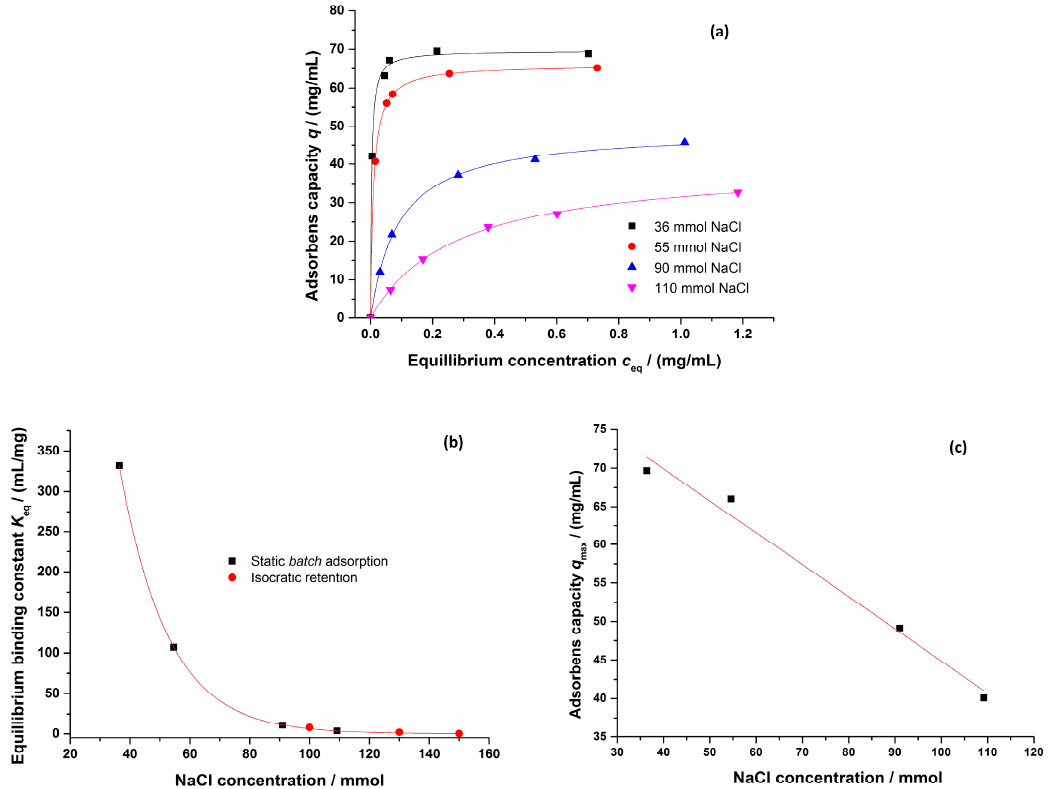
Figure 7. ( a ) Binding isotherms determined for purified mAb1; ( b ) Exponential regression of the equilibrium binding constant dependence on the NaCl concentration; ( c ) Linear regression of the maximum adsorbens capacity dependence on the NaCl concentration. Buffer: 10 mM KPi, pH = 6, various NaCl concentrations.